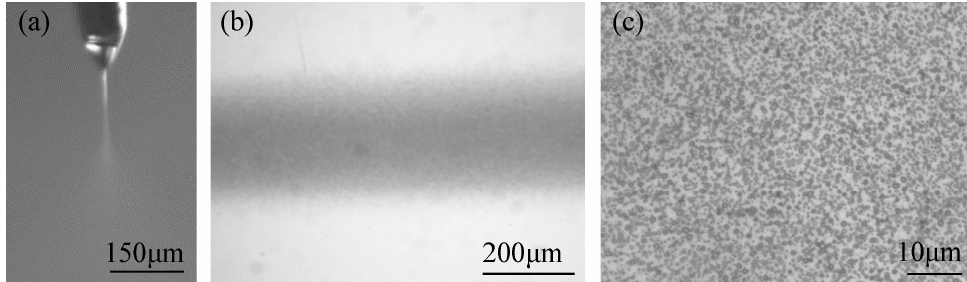
Figure 2. The printing process of near-field electrospray. ( a ) Ejection and motion behavior of the electrospray jet; ( b ) optical image of the deposited electrospray line; ( c ) optical image of the electrospray nanoparticles. The applied voltage, the flow rate of solution, the velocity of substrate, the distance between nozzle and collector, and the deposition time were 1.5 kV, 50 μ L/h, 5 mm/s, 5 mm and 2 s, respectively.